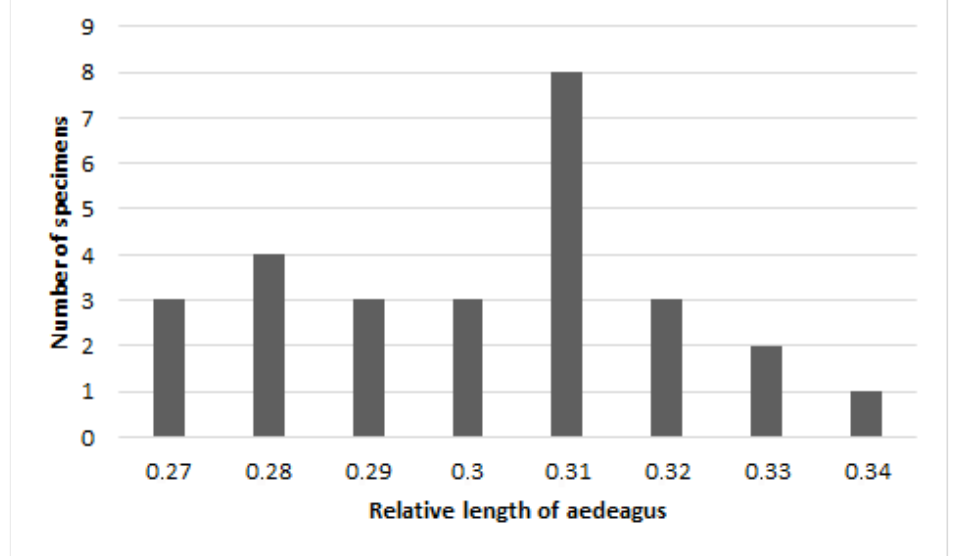
Figure 5. Chrysolina fascinatrix , relative length of male aedeagus.